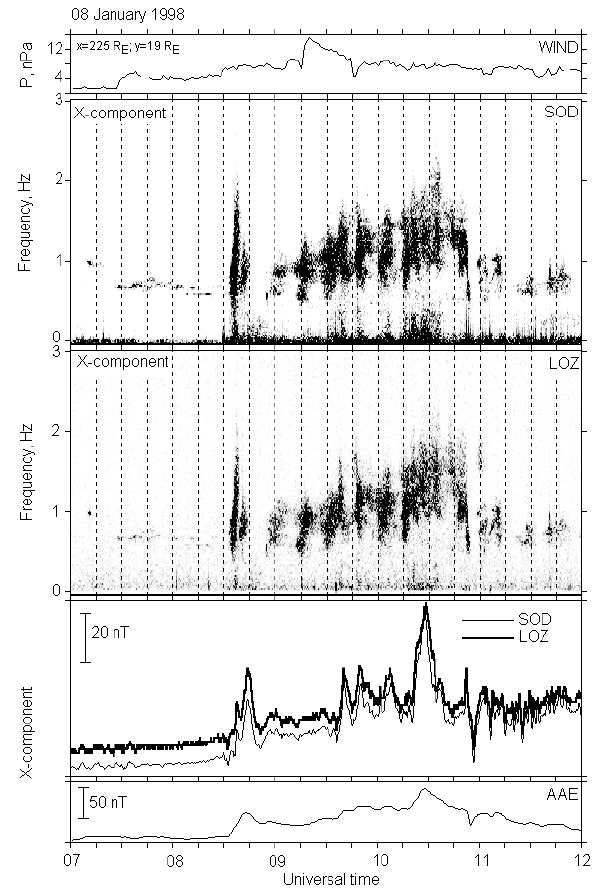
Fig. 2. An example of series of ULF bursts excited by a sudden change in solar wind dynamic pressure. From top to bottom: the so- lar wind pressure variations at the WIND satellite, sonograms from two magnetic stations (Lovozero and Sodankyla), variation of the geomagnetic field in the auroral zone and at the equatorial station Addis